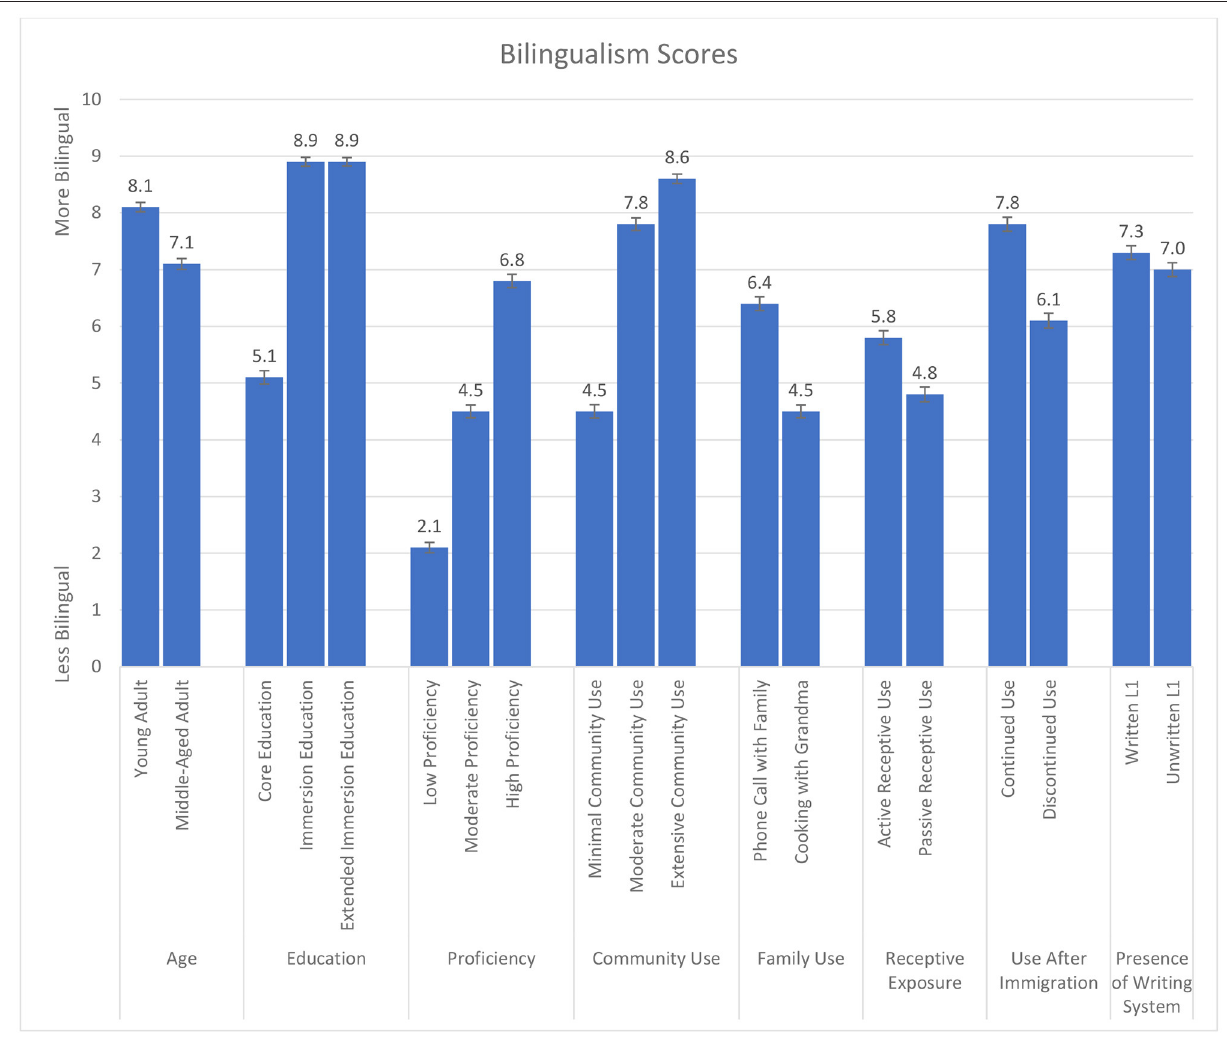
ANOVA comparing two age groups (young adult and middle- aged) was conducted to examine the effects of time since second language education. The effect of age was significant, F (1,527) = than those who are now in middle